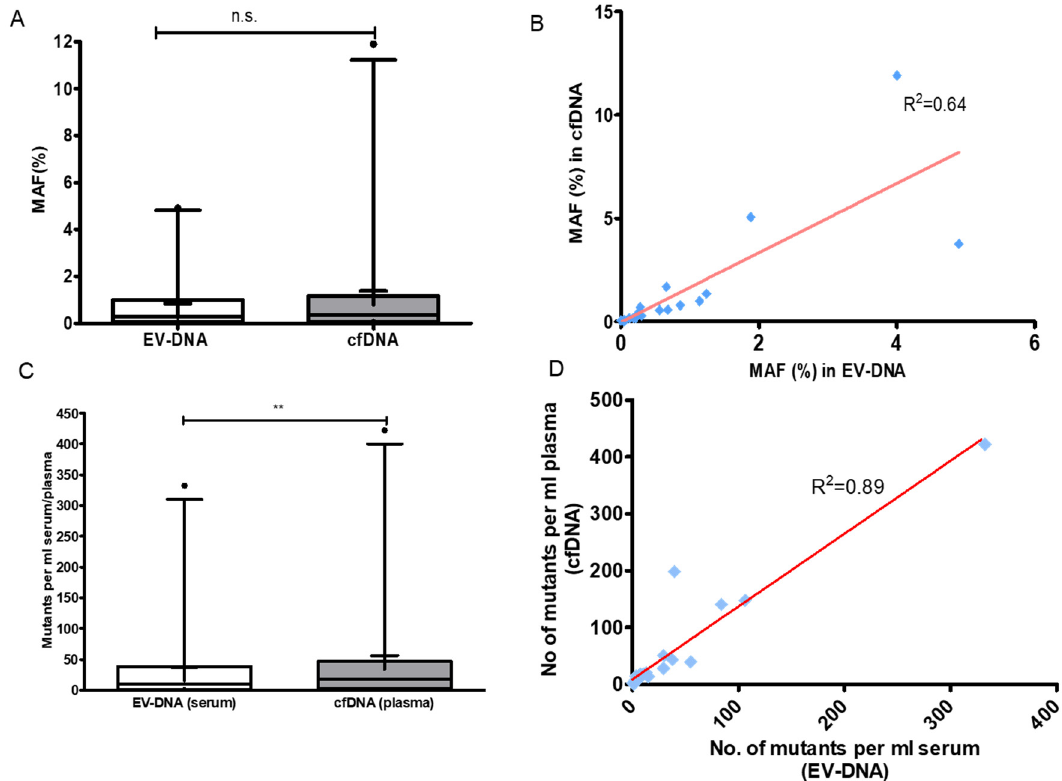
Figure 3. Comparison of mutant allele frequency (MAF) and mutant per mL serum/plasma in EV-DNA vs. cfDNA. ( A ) Box plot to show the comparison of MAF in EV-DNA and cfDNA. No significant difference was found between them ( p value = 0.316; Wilcoxon matched pairs signed test, n.s.—not significant). Whiskers represent 5th and 95th percentile and mean shown by + in box plot. ( B ) Scatter plot shows correlation between MAF in EV-DNA and cfDNA ( p value < 0.001, R 2 = coefficient of determination, blue squares represent MAF in EV-DNA and cfDNA). ( C ) Box plot shows that the number of copies of mutants were more in cfDNA than in EV-DNA ( p value = 0.003; Wilcoxon matched pairs signed test, Whiskers represent 5th and 95th percentile and mean shown by + in box plot). ( D ) Scatter plot shows correlation between number of copies of mutants in cfDNA and EV-DNA (p value < 0.001, R 2 = coefficient of determination, blue squares represent mutants per mL serum/plasma). ** refers to p ≤ 0.01.